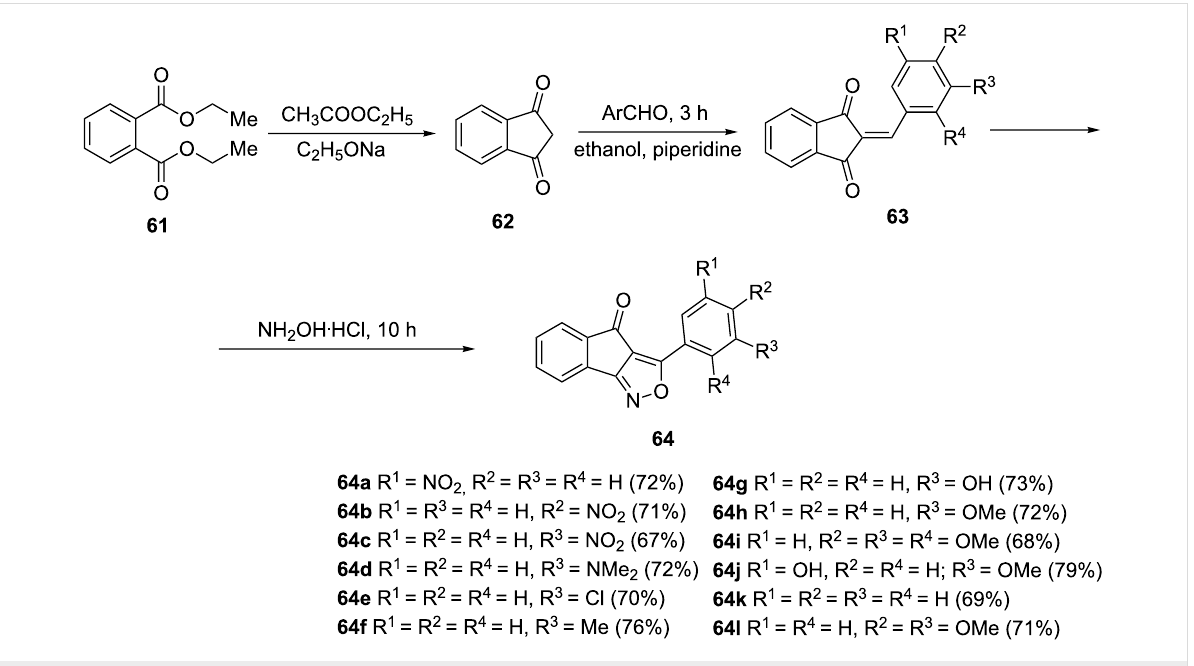
Scheme 21: Synthesis of 1-indanones 64 from diethyl phthalate 61 .